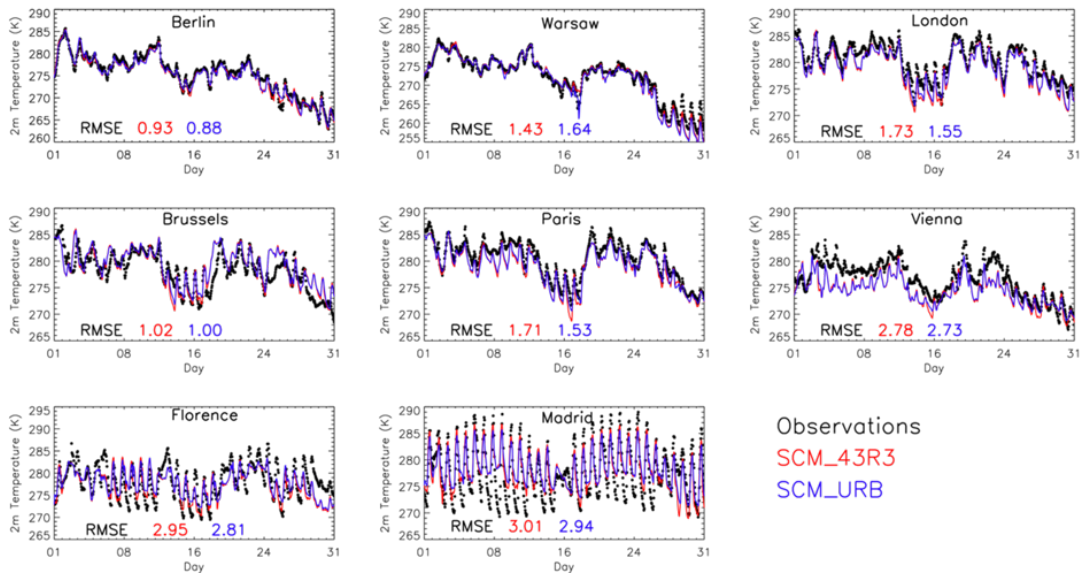
Figure 25. Hourly observed 2 m temperature taken from 8 urban sites for January 2012 (black circles); also shown are single-column model results using the control model (SCM_43R3: red) and the optimised urban scheme (SCM-URB: blue). Numbers indicate RMSE values when compared to observations (adapted from